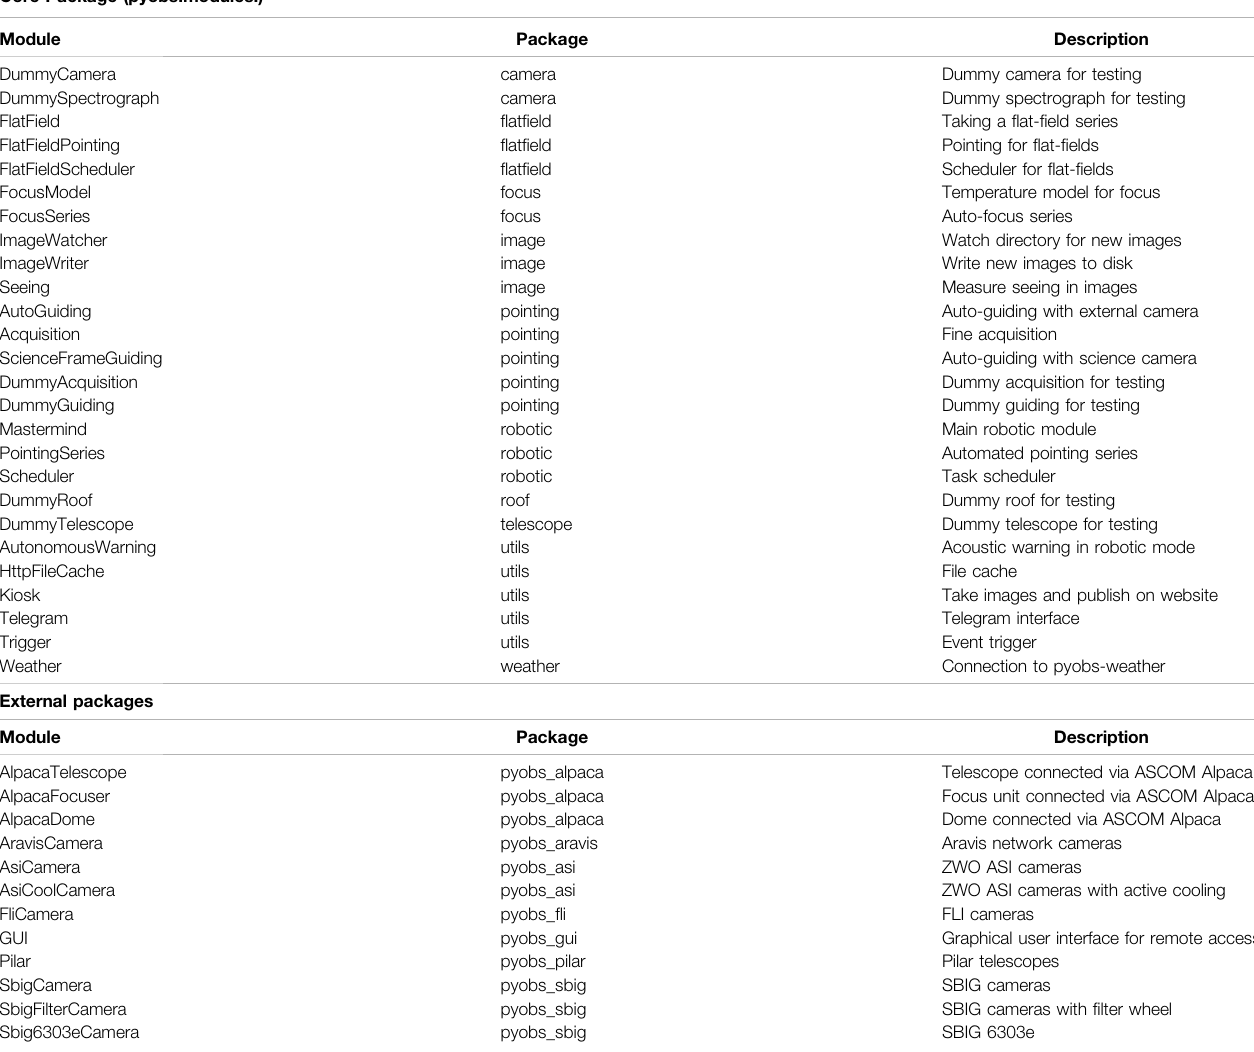
TABLE 1 | List of available modules in the core package and in external packages. Core Package